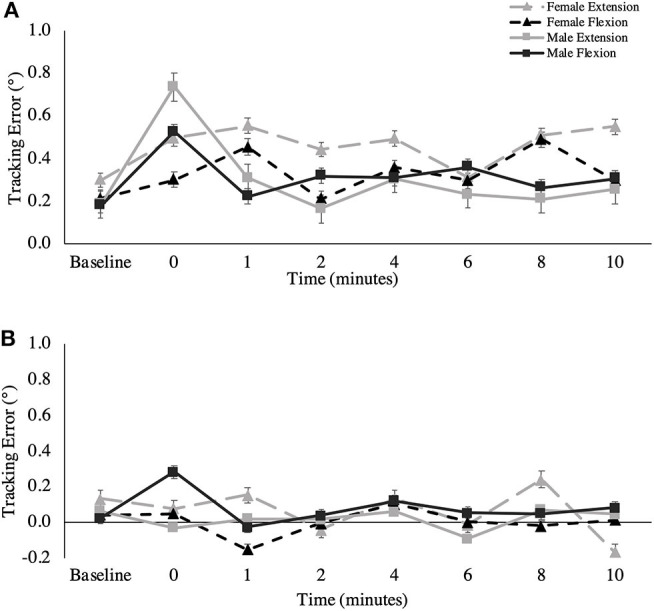
(A) Longitudinal and (B) normal component of tracking error (degrees) across all recovery time points. This metric is presented as group averages (with standard error bars). The data is separated by sex and muscle group.